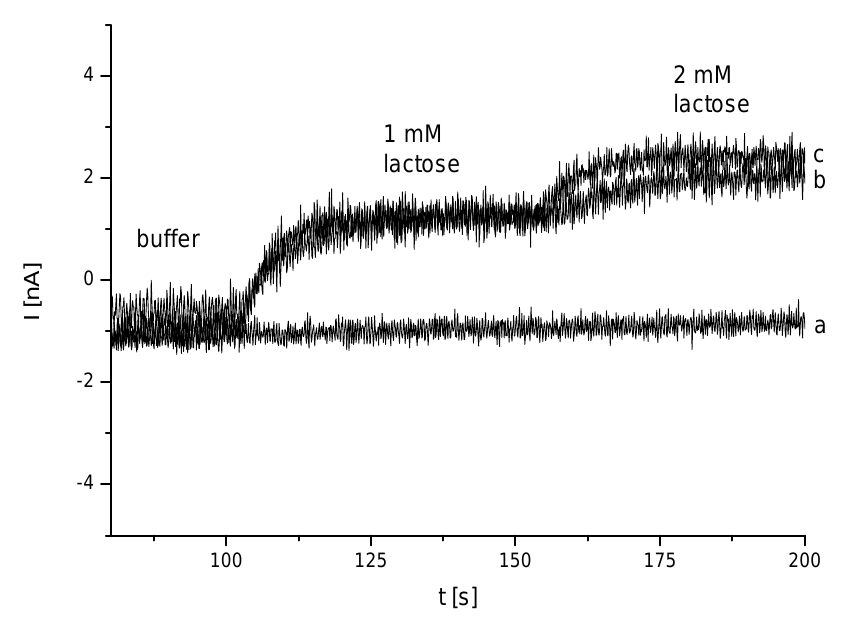
Figure 7. Amperometric measurement of Au-MPA-[MWCNT-P(AMB-A)-PDA]/CDH at ( a ) − 100 mV, ( b ) ±0 mV and ( c ) +100 mV (100 mM acetate buffer pH 4.5; vs . Ag/Ag/Cl, 1 M